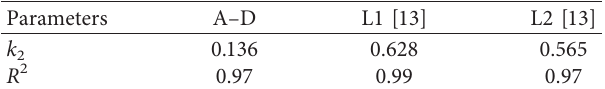
Table 8: Fitting parameter in the relationship between the moisture content increment and water pressure. Parameters